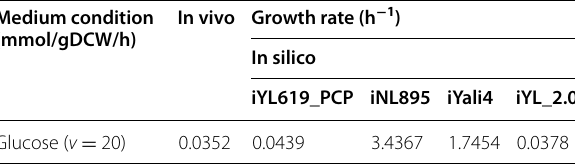
Table 2 Comparison of in silico and in vivo